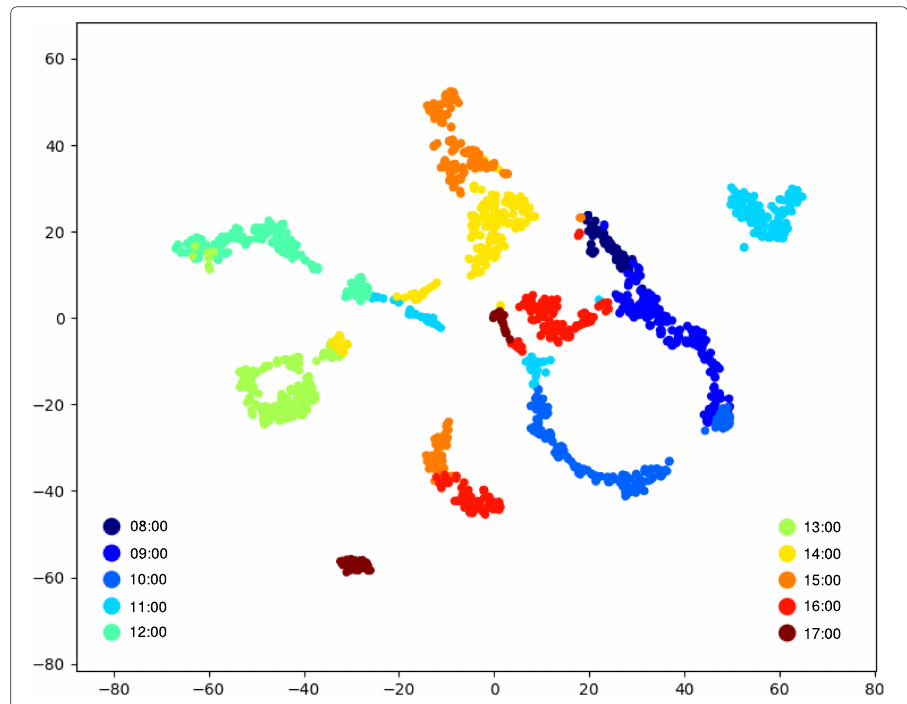
Fig. 6 Visualization for primary school embeddings. Each point represents a network snapshot during the day of the 01-October-2009. Color of points encode a time frame of the day spanning from 8:45 until